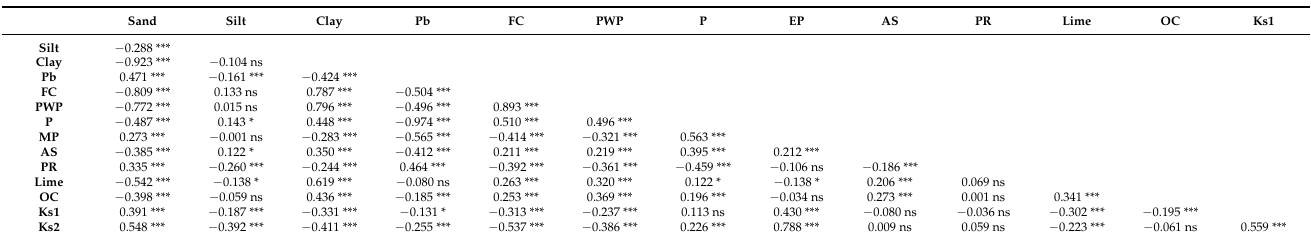
Table 2. Correlation matrix between Ks values and soil